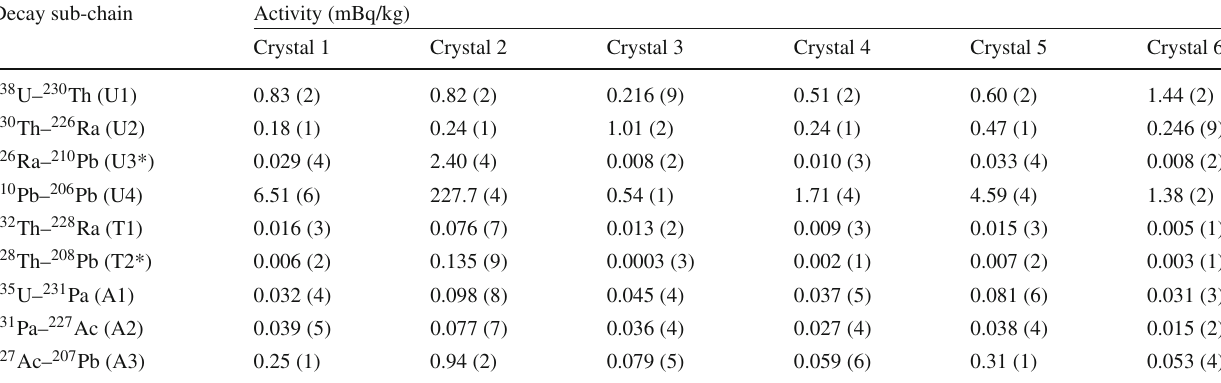
Table 3 Radioactive contamination of the CMO crystal scintillators (see the text). They are obtained with a rough estimate integrating a ± 40 keV range around peaks. U3* and T2* are obtained by α - α coincidence events. The numbers in the parentheses are only statistical uncertainties Decay sub-chain